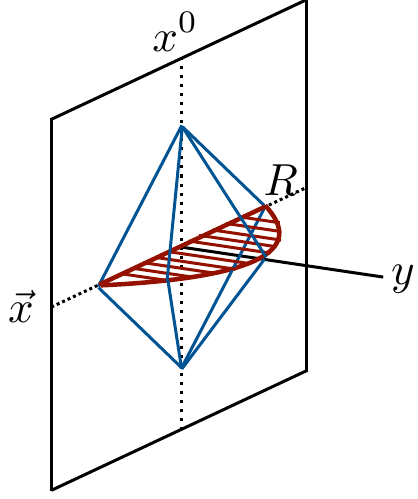
Figure 1 . The entangling region is determined by a half-sphere of radius R centered at the boundary y = 0. The (cid:12)gure also shows the causal diamond of this